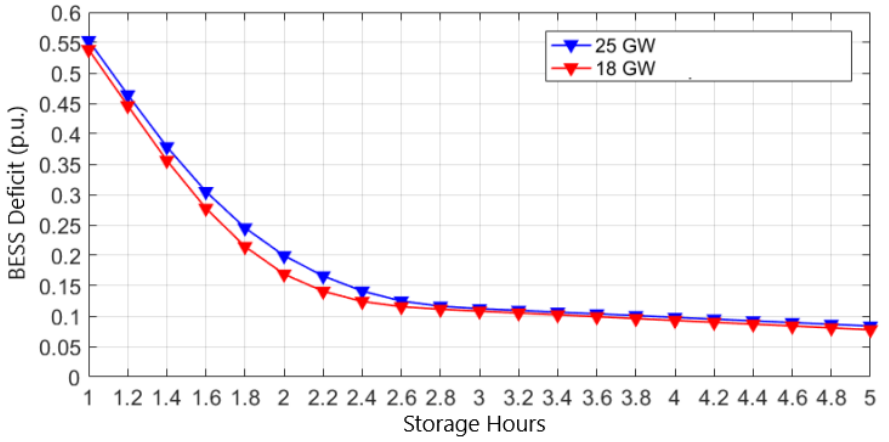
Figure 4. Result of BESS noncompliance for 18 GW and 25 GW of wind penetration